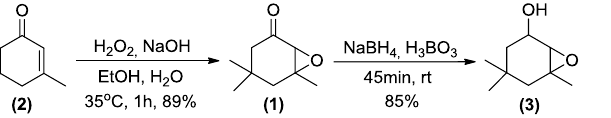
Figure 4. Synthesis of the racemate of epoxyisophorone ( 1 ) and a mixture of all the possible stereoisomers of homalinol ( 3 ), from isophorone ( 2 ).